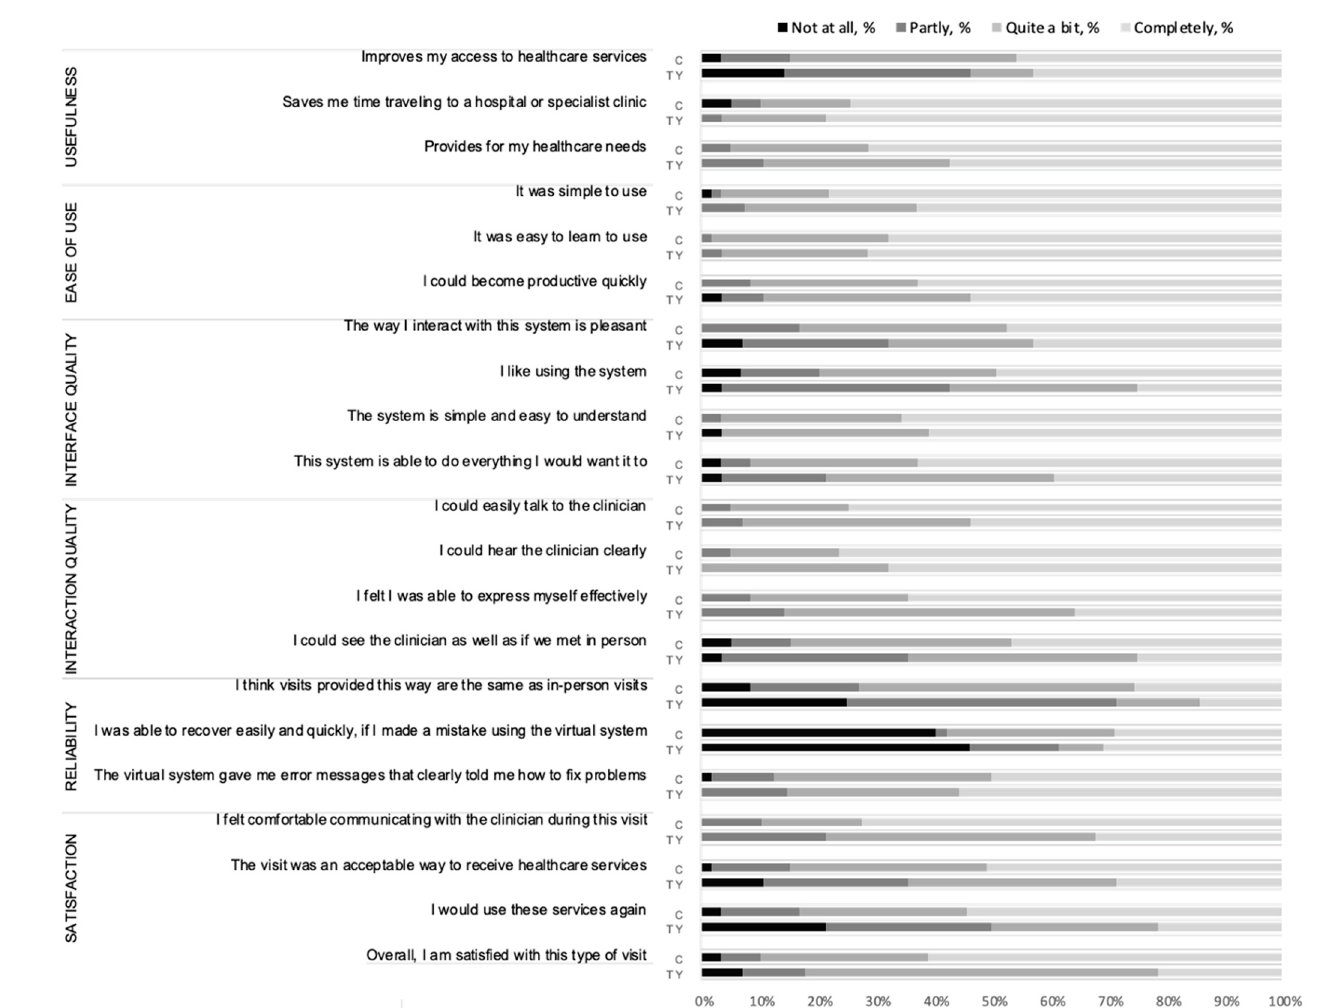
Figure 1. Usability of virtual gender visits for caregivers and trans youth: distribution of responses to the Telehealth Usability Questionnaire. C = caregivers; TY = trans youth.